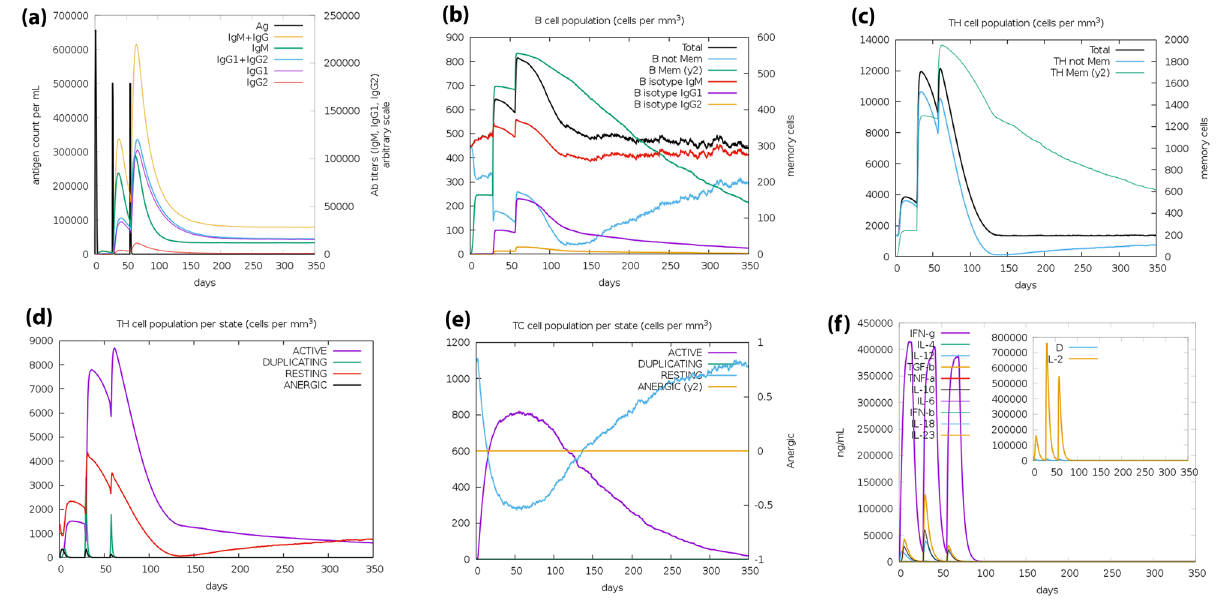
Figure 12. Simulation of the immune response against H7N9vac construct. ( a ) Immunoglobulins level after incitement by H7N9v construct. ( b ) Amount of B memory (y2) and total B isotype (IgM, IgG1, IgG2) as the immune response. ( c ) CD4 T-helper lymphocytes as a function of T-helper evolution. ( d ) Showing total and memory T-helper lymphocytes. ( e ) CD8 T-cytotoxic lymphocytes cell populations per state in response to antigen injection. ( f ) Produced IFN-γ concentration and IL-4, IL6 and